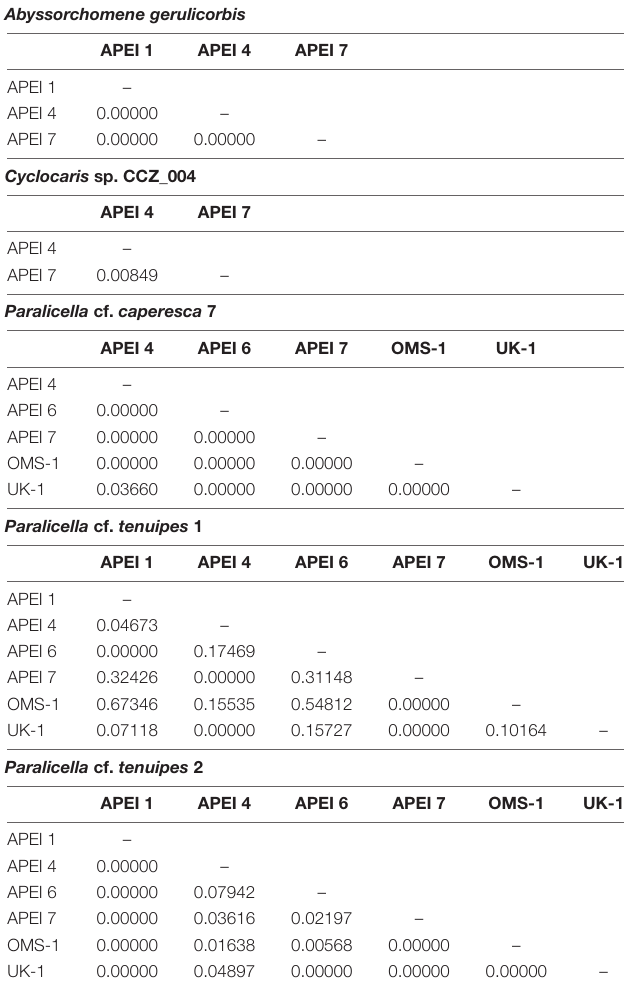
TABLE 4 | Pairwise Fixation index (FST) for genetic species of scavenging amphipods collected in different areas within the Clarion-Clipperton Zone (CCZ). Abyssorchomene